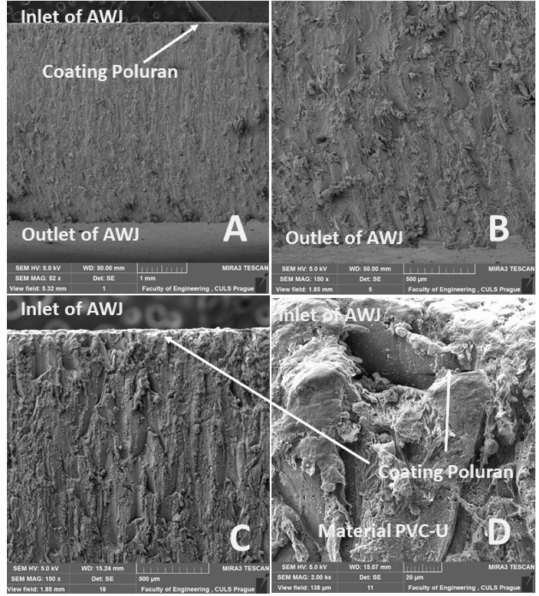
Figure 22. Cutting view of the tested PVC-U + POLURAN, AWJ technology, cutting head traverse speed 1000 mm · min − 1 : ( A ) overall cut (MAG 52 × ); ( B ) detailed view of the outlet of AWJ (MAG 150 × ); ( C ) detailed view of the inlet of AWJ (MAG 500 × ); ( D ) detailed view of the interface of POLURAN coating and PVC-U material (2000 × ).